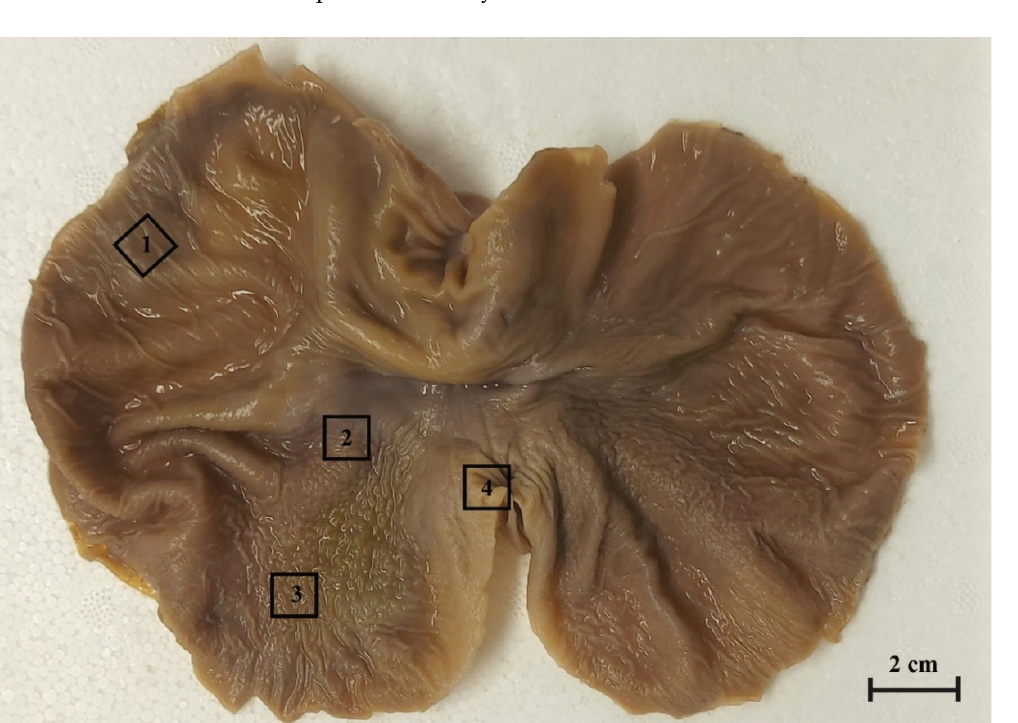
Figure 1. The gastric mucosa of equine foetal stomach (the 3rd age group) with the rectangular marks of sample collection areas. 1. the blind ventricular sac, 2. the plicated margin edge/cardiac part, 3. the body of stomach, 4. the pyloric